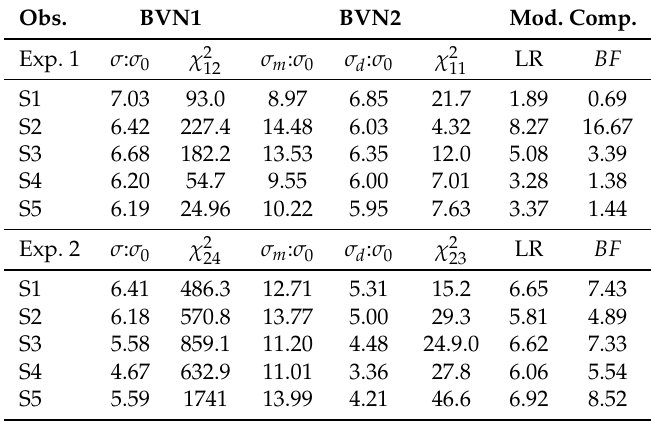
Table A1. Noise ratios (%), goodness-of-fit ( χ 2 ), and model comparison for Bayesian vector normal model with one (BVN1) and two noise parameters (BVN2) in Exp. 1 (slanted lines) and Exp. 2 (tilted and slanted lines). Model comparison in terms of likelihood ratio LR and Bayes factor BF . Obs. BVN2 Mod.